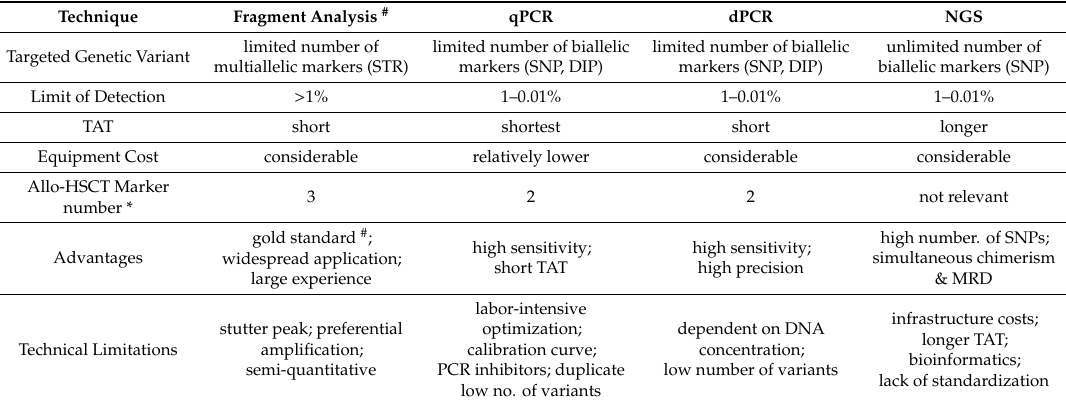
Table 1. Comparison of chimerism / microchimerism laboratory detection